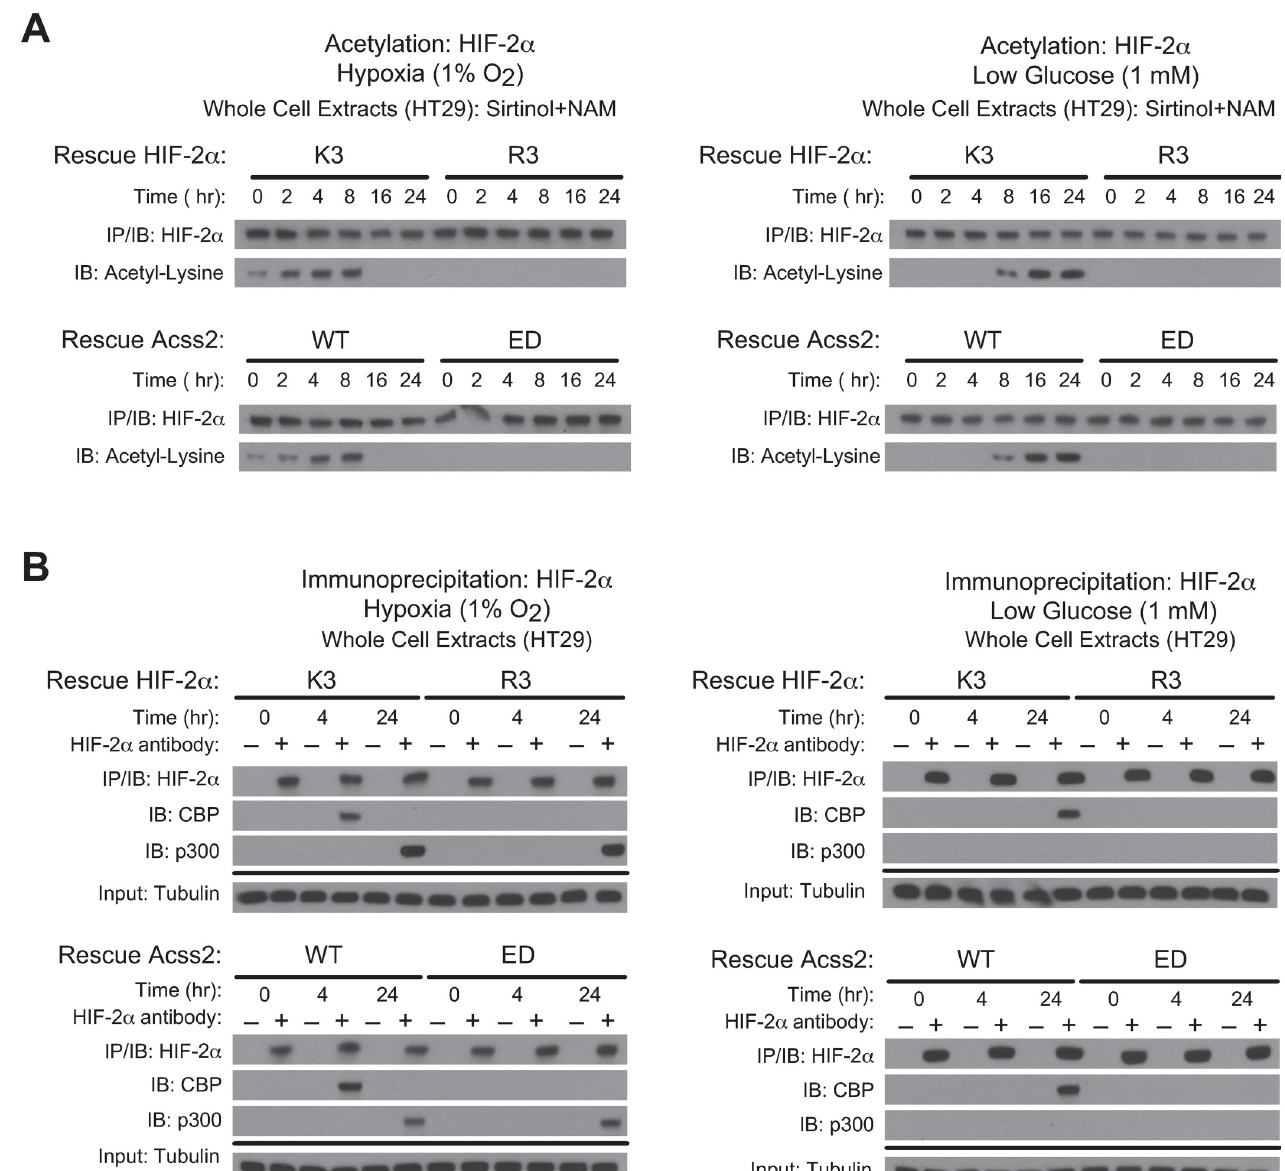
Fig 4. Acss2/Cbp/HIF-2 α interactions in HT29 cells. (A) Acetylation detected by immunoblotting (IB) of ectopic HIF-2 α in HIF-2 α knockdown HT-29 cells rescued with wild-type (K3) or arginine-lysine substituted mutant (R3) HIF-2 α (upper panel), or of endogenous HIF-2 α in Acss2 knockdown HT29 cells rescued with wild-type (WT) or cytosol-restricted mutant (ED) Acss2 (lower panel), following immunoprecipitation (IP) after the indicated period of hypoxia exposure (left side) or glucose deprivation (right side). (B) Interactions of endogenous Cbp or p300 with ectopic HIF-2 α in HIF-2 α knockdown HT29 cells rescued with wild-type (K3) or arginine-lysine substituted mutant (R3) HIF-2 α (upper panel), or with endogenous HIF-2 α in Acss2 knockdown HT29 cells rescued with wild-type (WT) or cytosol-restricted mutant (ED) Acss2 (lower panel), detected by immunoblotting following immunoprecipitation after hypoxia exposure (left side) or glucose deprivation (right